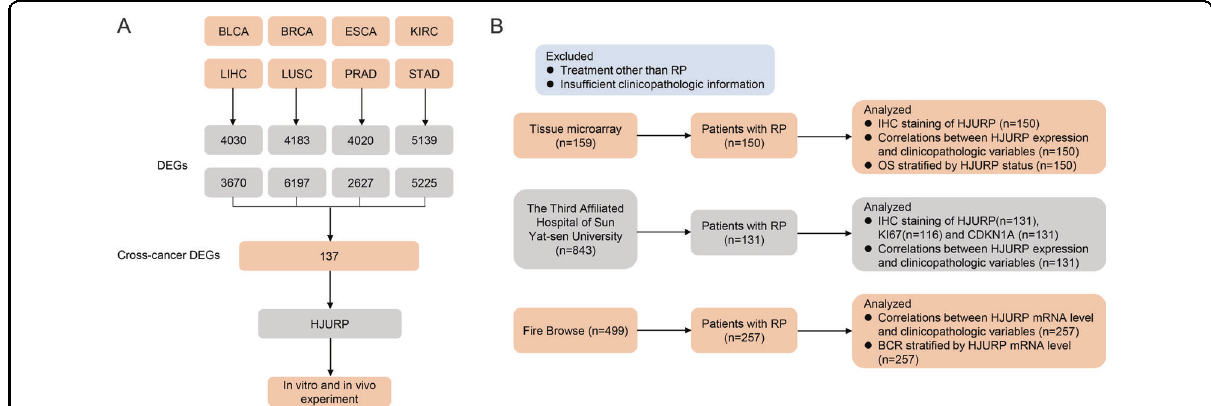
Fig. 1 Flowchart depicting study enrollment. A Screening of cross-oncogene in eight tumors. B The patients with prostate cancer enrolled in this study. BLCA bladder urothelial carcinoma, BRCA breast invasive carcinoma, ESCA esophageal carcinoma, KIRC kidney renal clear cell carcinoma, LIHC liver hepatocellular carcinoma, LUSC lung squamous cell carcinoma, PRAD prostate adenocarcinoma, STAD stomach adenocarcinoma, DEGs differentially expressed genes, RP radical prostatectomy, IHC Immunohistochemistry, OS overall survival, BCR biochemical